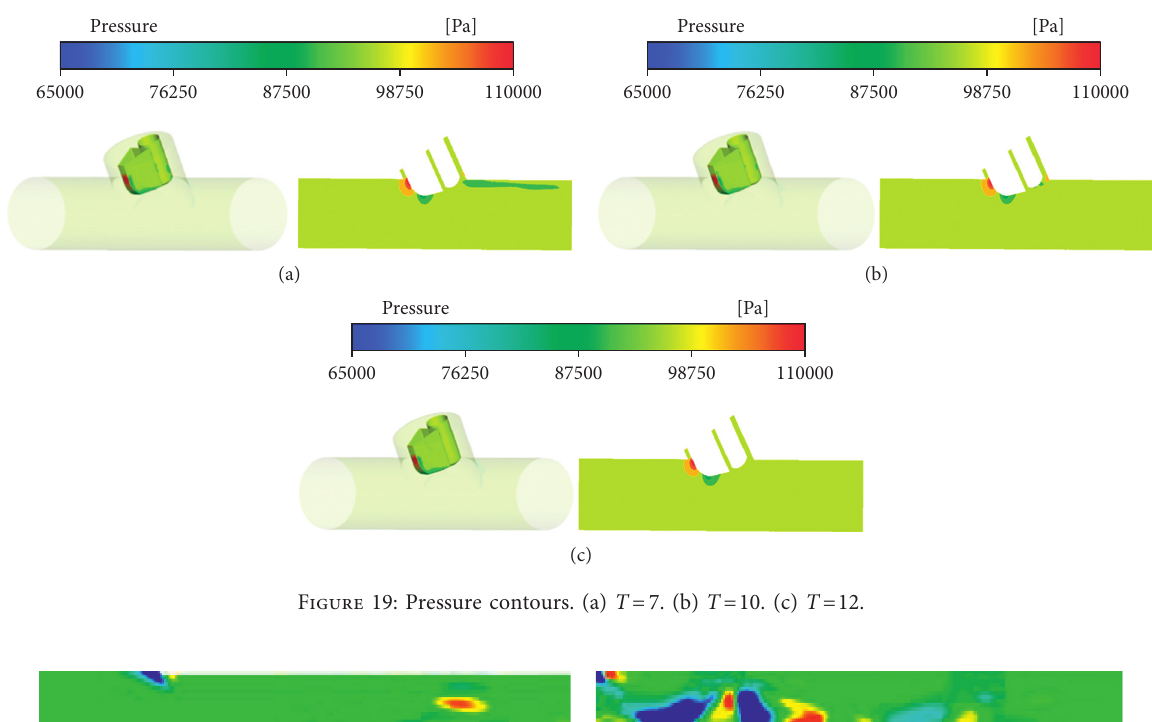
Figure 19: Pressure contours. (a) T � 7. (b) T � 10. (c) T � 12.